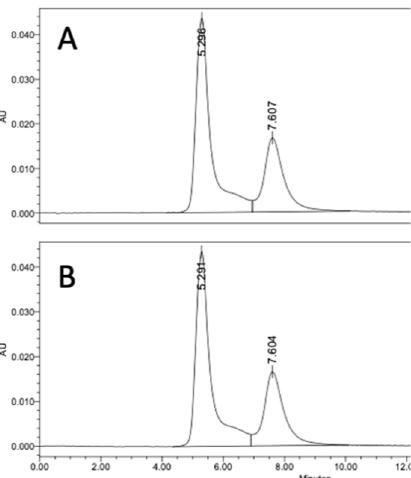
Figure 6. Activation of dextran in DMAP buffer. DMAP was added prior to ( A ) or after ( B ) the addition of 0.5 mg CDAP/mg dextran. The pH was maintained at pH 9 with 0.1 M NaOH for 15 min followed by conjugation to TNP-BSA. The reaction was maintained on ice. Conjugates were analyzed using a Tosoh (King of Prussia, PA, USA) G4000 SEC HPLC column, with detection at 420 nm. The high molecular weight protein was considered conjugate.